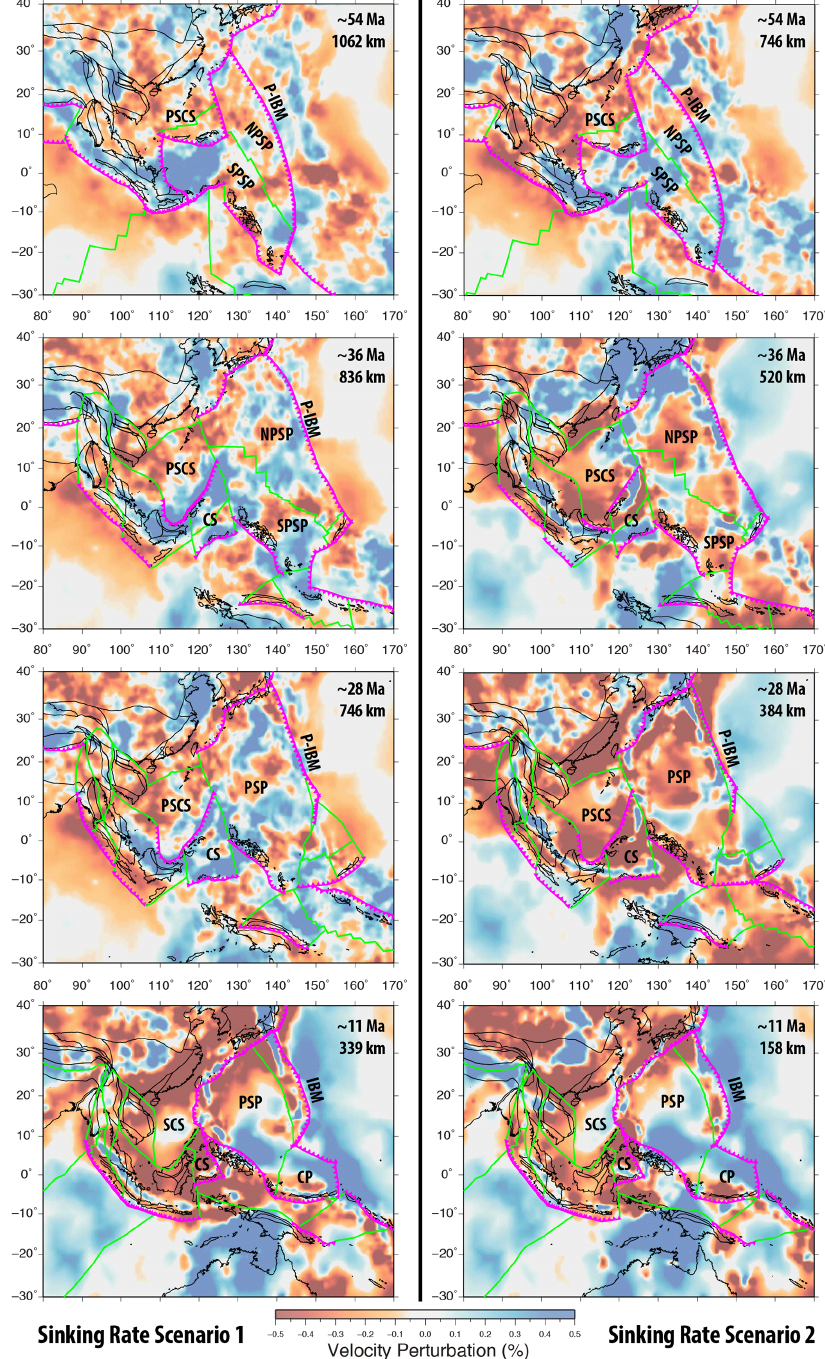
Fig. 8. Plate reconstructions superimposed on age-coded depth slices of MIT-P (Li et al., 2008) seismic tomography with two end-member sinking rate scenarios. Scenario 1 (left) applies a 3 and 1.2cmyr − 1 sinking rate of slabs in the upper and lower mantle, respectively, following Zahirovic et al. (2012). Scenario 2 (right) applies a whole-mantle slab sinking rate of 1.4cmyr − 1 as a low sinking rate end- member. The longitudinal position of the Philippine Sea Plate (PSP) is calibrated to the location of the slab material to coincide with the modeled subduction zone geometries. In addition, convergence along the Australian and Pacific segments was preserved to minimize trench advance, and account for the rollback of the Pacific slab and coupling to the Izu–Bonin–Mariana (IBM) Arc resulting in the opening of the Shikoku and Parece Vela basins. Reconstructed present-day coastlines (black) and plate boundaries (MORs/transforms–green, subduction zones–magenta) are plotted for reference. CP–Caroline Plate, CS–Celebes Sea, SCS–South China Sea, PSCS–proto-South China Sea, NPSP–northern Philippine Sea plate, SPSP–southern Philippine Sea plate, (P-) IBM–(proto-)Izu–Bonin–Mariana Arc. www.solid-earth.net/5/227/2014/ Solid Earth, 5, 227–273,